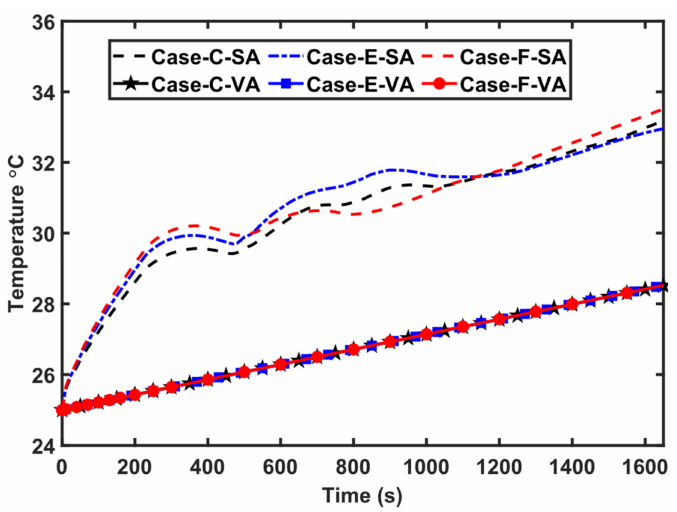
Figure 5. Sensitivity study for the penetration length for the steam condensation region. The figure shows the temporal variation in surface average and bulk average temperatures. Cases C, E and F represent penetration lengths of 25 mm, 15 mm, and 10 mm,